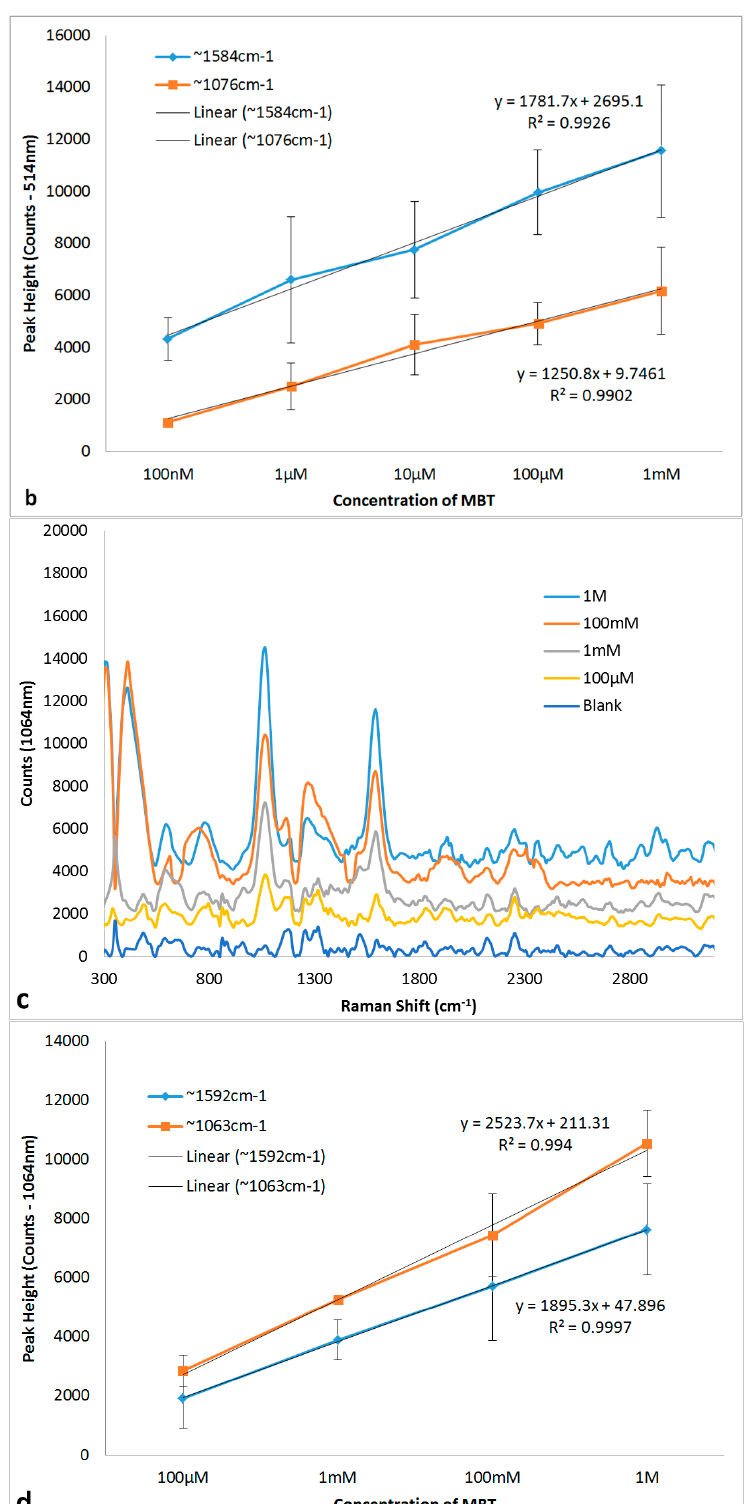
Figure 8. SERS spectra for MBT ( a , c ) as a function of concentration and their corresponding standard curves for the peaks ~1076 cm − 1 and ~1584 cm − 1 ( b , d ) recorded using 514 nm ( a , b ) and 1064 nm ( c , d ) Raman spectrometers. The SERS spectra ( a , c ) are offset by 1000 cm − 1 for clarity. The peak heights ( b , d ) are presented as mean ± standard error of mean (n = 6).